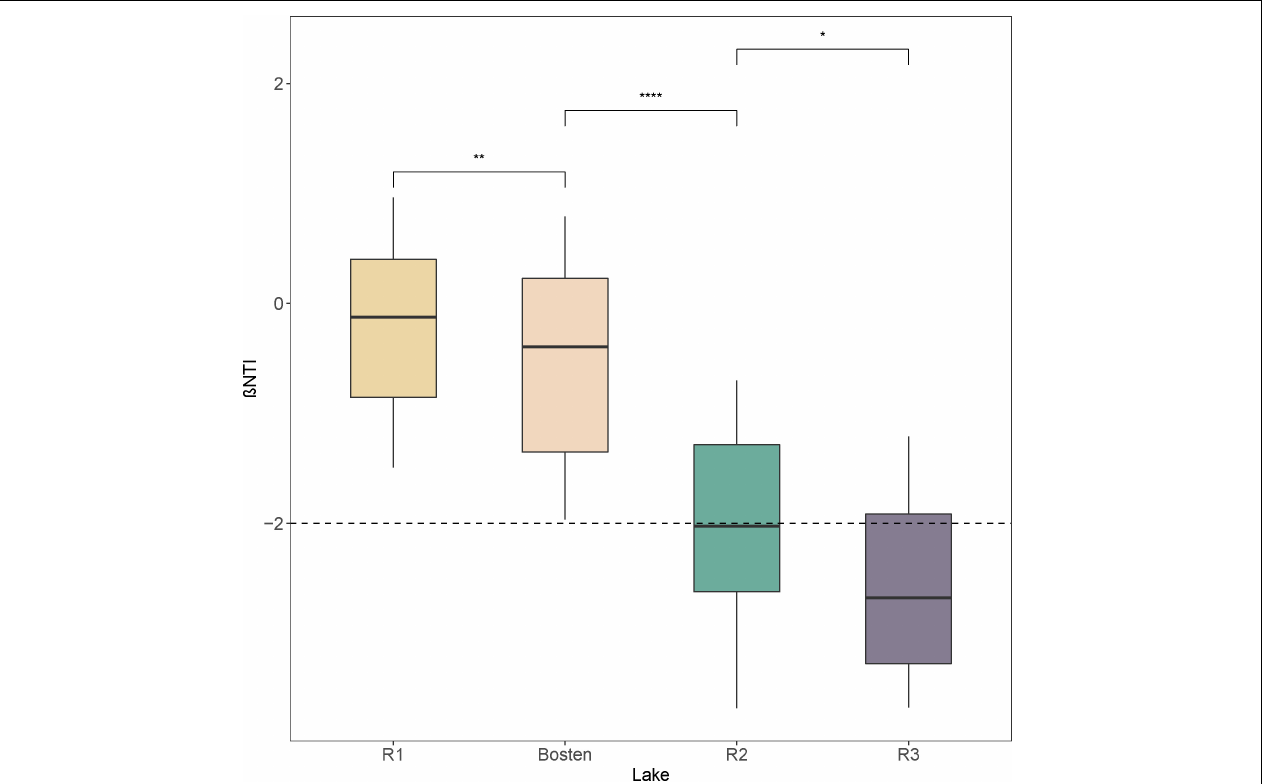
FIGURE 4 | The beta nearest taxon index ( β NTI) of bacterial communities among the four lakes. Significance levels: * p -value < 0.05; ** p -value < 0.01; *** p -value < 0.001.